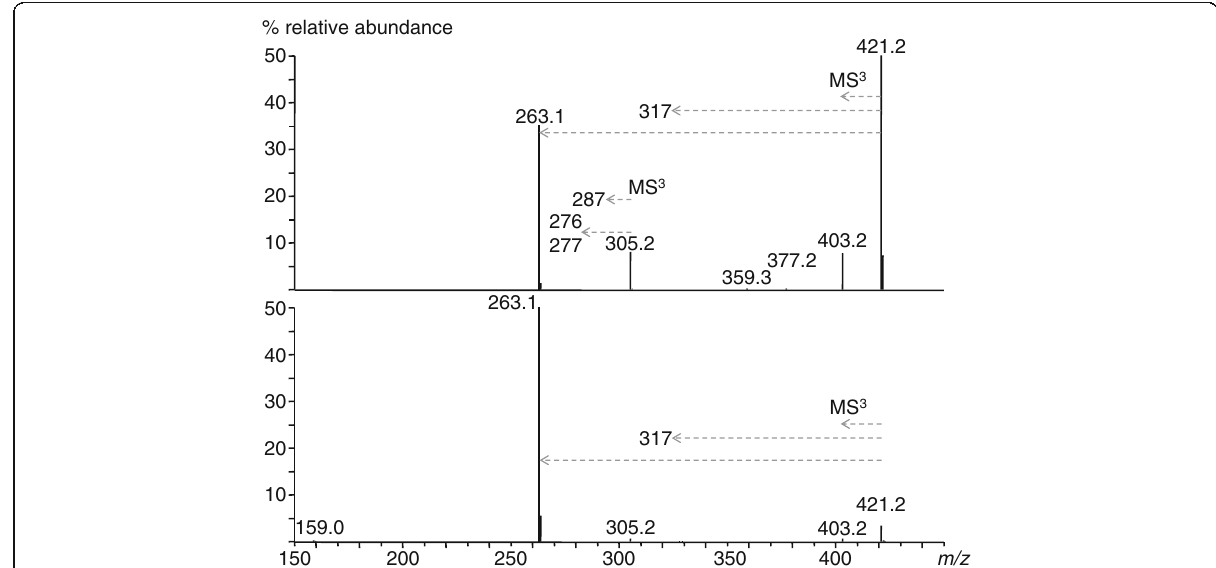
Fig. 1 CID product ion spectra of m/z 439.1 of glucuronides 2 (upper spectrum) and 3 (lower spectrum) magnified by a factor of two. Important MS 3 fragments are indicated by dashed